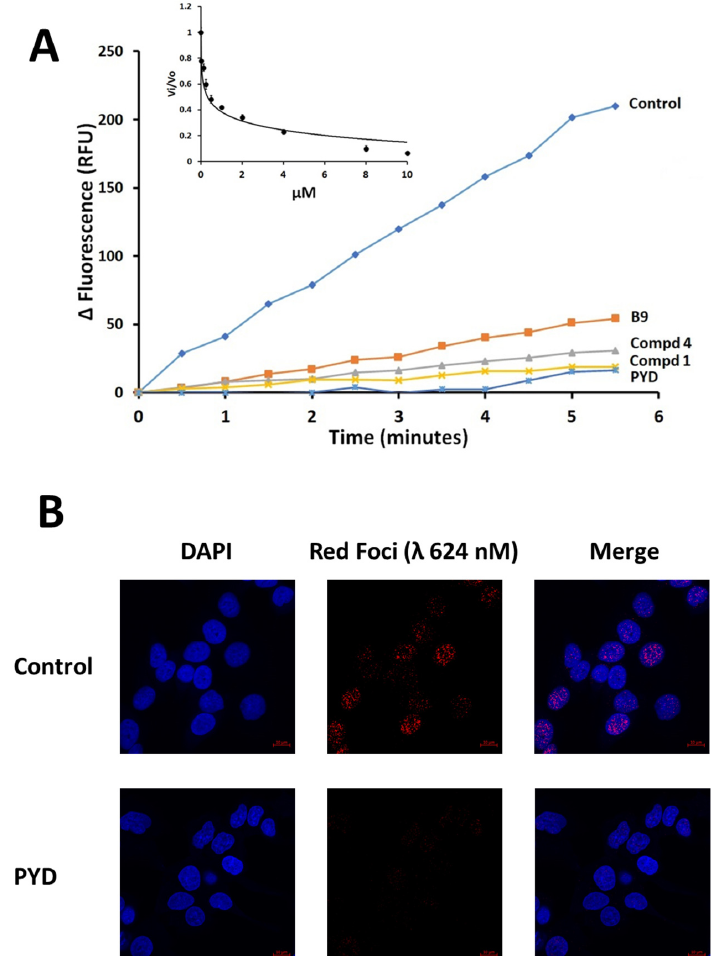
Figure 3. Inhibition of ERCC1-XPF by pyronaridine (PYD). ( A ) Representative plots of fluorescence generated by ERCC1-XPF catalyzed incision of a fluorescently quenched stem-loop DNA substrate containing fluorescein (FAM) and dabcyl groups at the 5 ′ - and 3 ′ -termini, respectively. The incision releases a FAM-labeled oligonucleotide from the quenching caused by close juxtaposition to the dabcyl group. Control represents the substrate incision by the uninhibited enzyme exposed only to the equivalent amount of DMSO vehicle . Other compounds shown for comparison are B9: 2-chloro-9-((3-((4-(2-(dimethylamino)ethyl)piperazin-1-yl)methyl)-4-hydroxyphenyl)amino)acridin-2-ol; Cmpd4: 4-((6-chloro-2-methoxyacridin-9-yl) amino)-2-((4-(2-(dimethylamino)ethyl) piperazin-1-yl) methyl)phenol; Cmpd1: 4-((6-chloro-2-methoxyacridin-9-yl)amino)-2-((4-(2-(diisopropylamino)ethyl)piperazin-1-yl)methyl)phenol. The inset shows the initial velocities (slopes) normalized by its value in the absence of compound vs. its value in the presence of increasing µM concentrations of PYD. The bars represent the S.D. of three different measurements for each point (R 2 = 0.95). ( B ) Representative PLA images of HCT-116 cells exposed to 2 µM of pyronaridine (PYD) or the equivalent amount of DMSO vehicle (1 µL/mL, Control). Images were obtained at 40X magnification. ERCC1-XPF complexes appear as red dots, and cellular nuclei are shown in blue after DAPI staining.